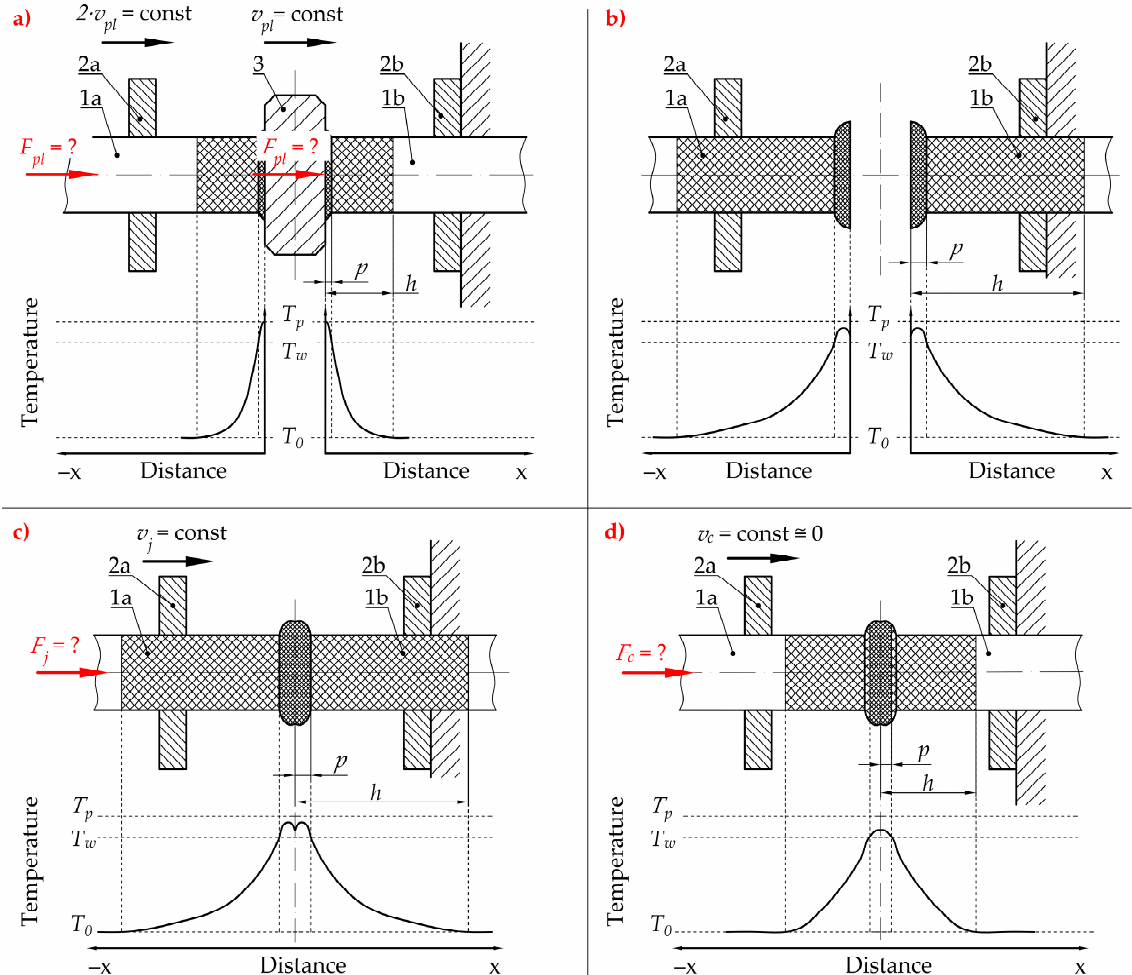
Figure 2. Diagram of the hot plate welding process of the drive belt divided into 4 phases: ( a ) plasticization, ( b ) removing the heating device, ( c ) joining (pressing), ( d ) cooling of the joint; 1a—movable end of the belt, 1b—fixed end of the belt, 2a—movable belt holder, 2b—fixed belt holder, 3—hot plate; v pl —plasticization velocity, v j —velocity of pressure during joining, v c —velocity of pressure during cooling, F pl —pressure force during belt plasticization, F j —pressure force when connecting the belt ends, F c —pressure force during cooling of the connection, T p —temperature of the hot plate, T w —welding temperature, T 0 —environment temperature, p —belt plasticization distance, h — distance heated to a temperature higher than environment temperature.